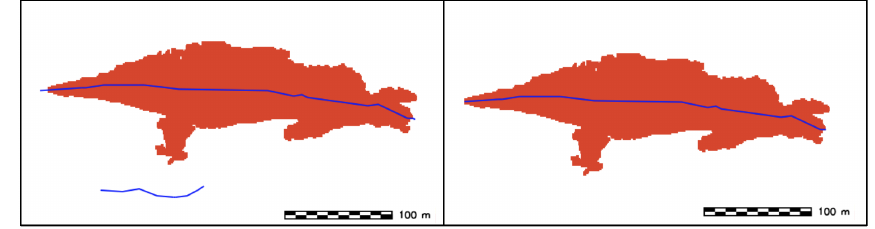
Figure 20. SWC clipping.